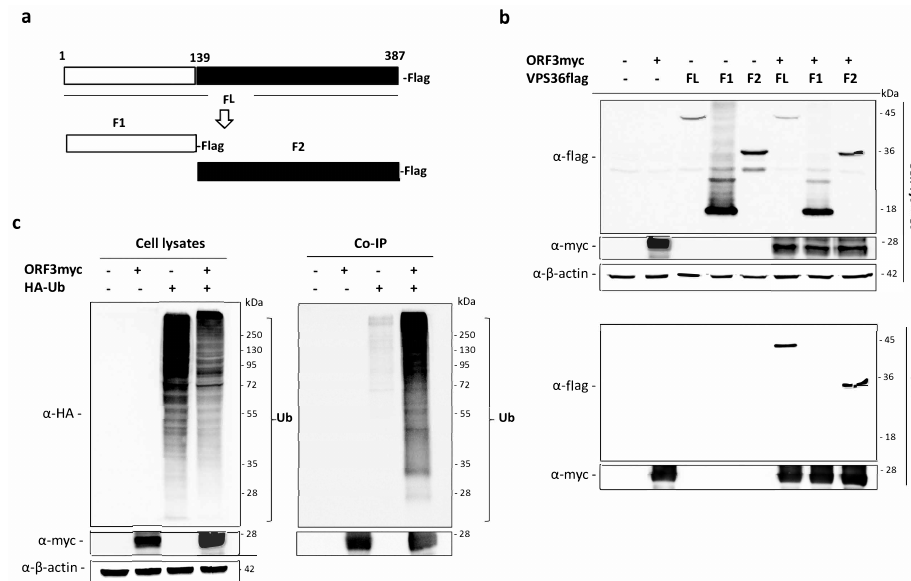
Figure 4. Ubiquitination of ORF3 and its binding with VPS36 domains. ( a ) Schematic